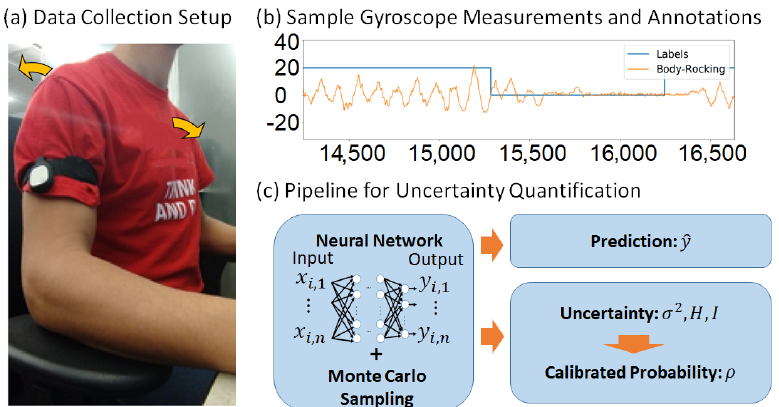
Figure 1. Illustration of the data collection, prediction, and uncertainty quantification pipelines. ( a ) Body-rocking movement illustration with sensor placed on the arm. The arrows indicate the forward and backward body rocking. ( b ) A sample gyroscope measurement with corresponding annotations. ( c ) Our pipeline for prediction and uncertainty, which uses a Bayesian Neural Network framework based on Monte Carlo (MC) Sampling from dropout. The uncertainty measures include a variance σ 2 indicative of observation noise, and entropy H and mutual information I obtained from the MC samples. This framework improves the performance of prediction and yields a calibrated probability ρ that is reliably indicating our confidence in a